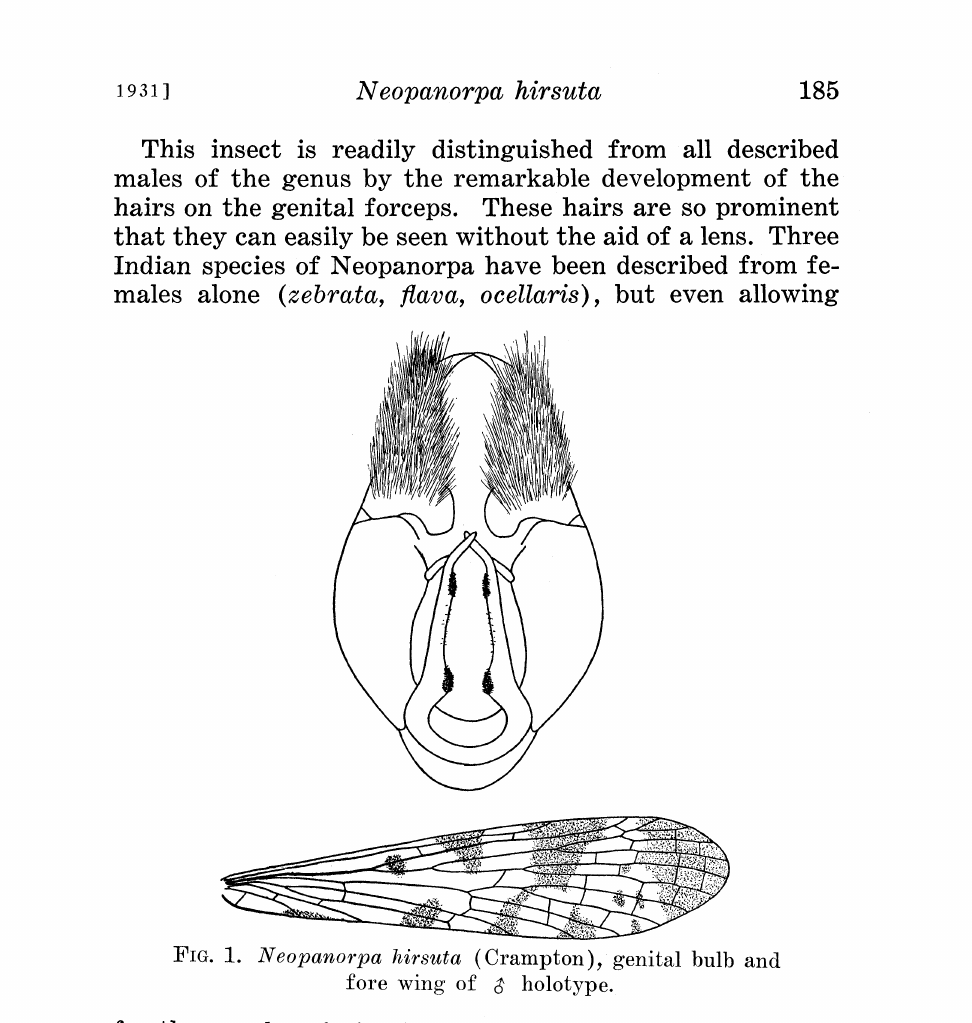
FIG. 1. Neopanorpa hirsuta (Crampton) genital bulb and fore wing of